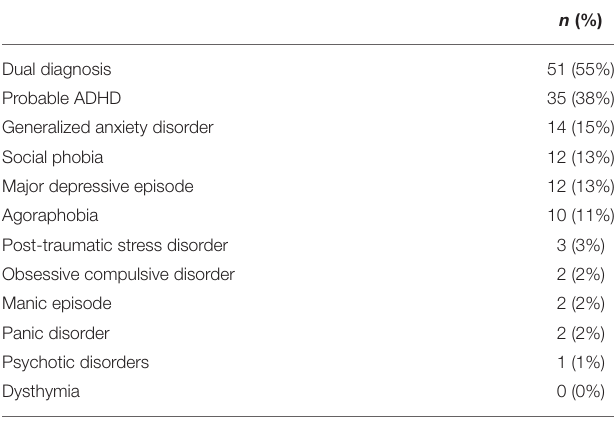
TABLE 2 | Prevalence of associated disorders ( N = 92).